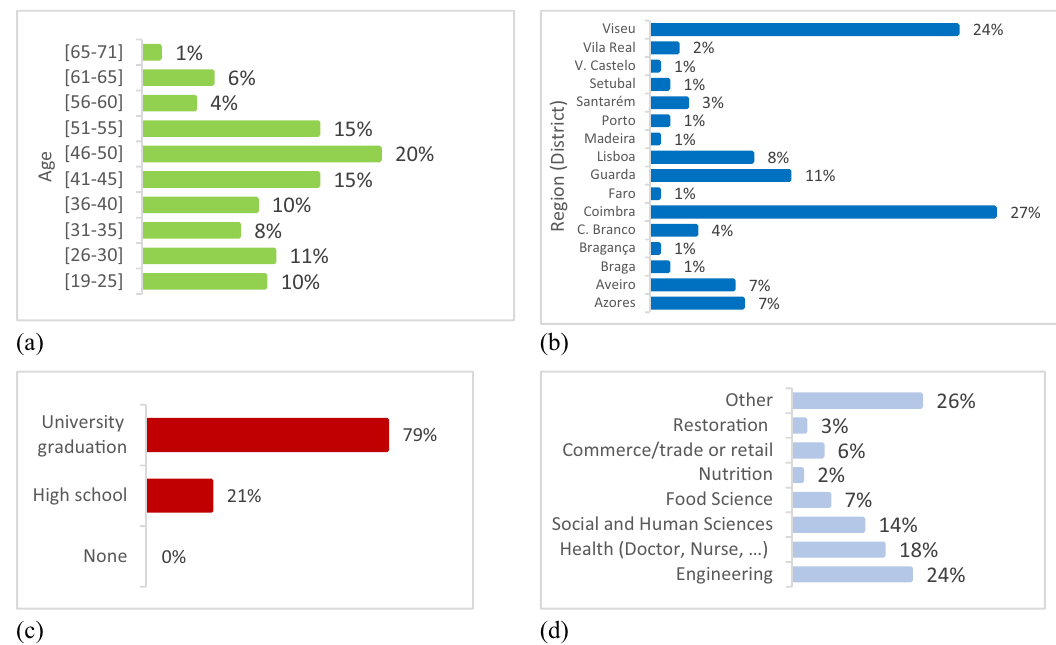
Figure 1: Sociodemographic information about the sample: ( a ) age distribution ( % ) of the participants ( years ) , ( b ) geographical distribution of participants, ( c ) participants academic graduation, and ( d ) main education or professional activity area. Values are presented in percentage, representing a sample of 136 individuals.